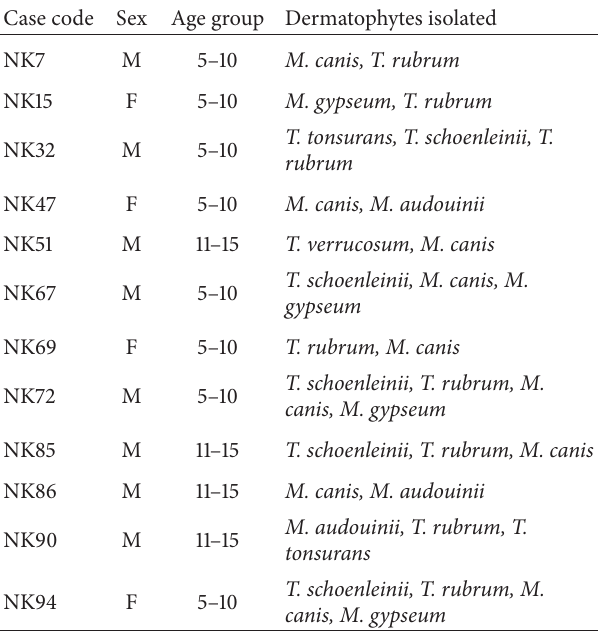
Table 3: Mixed dermatophyte infection among school children in Nok community, Kaduna State, with respect to age and